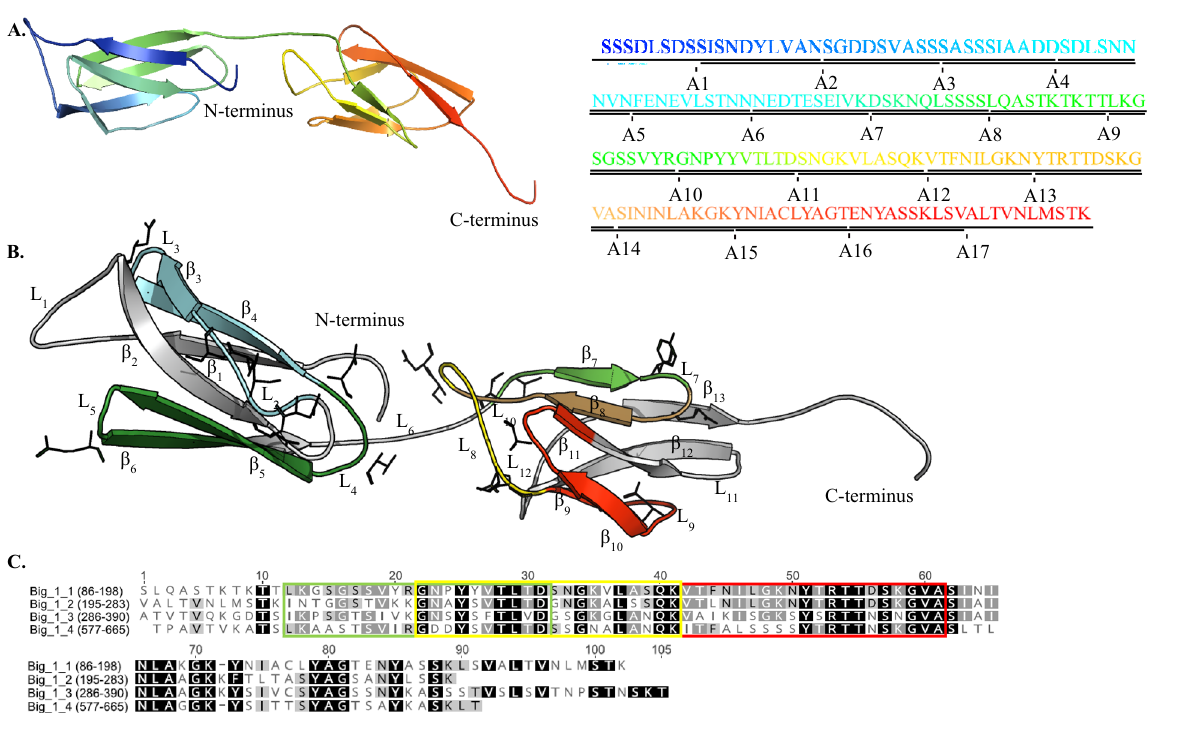
Figure 4. ( A ) The structure of AdLP_D1 was created using the online modelling server CPH version 3.2 28 and a crystal structure of a bacterial integrin binding protein (PDB code 1CWV) 29 . The AdLP-D1 secondary structure and peptide sequences are highlighted with the identical colors. ( B ) Positions of the immunogenic peptides A5 (cyan), A7 (green), A10 (light green), A11 (yellow) and A13 (red) on the structure of AdLP-D1. The overlapping region between A10 and A11 is in light brown. Polar and charged residues are also shown as side chains. ( C ) Multiple amino acid sequence alignment of the Big_1 domains of Mru_1499 using MUSCLE 51 alignment. Residues of the immunogenic peptides A10, A11 and A13 are highlighted in green, yellow and red boxes